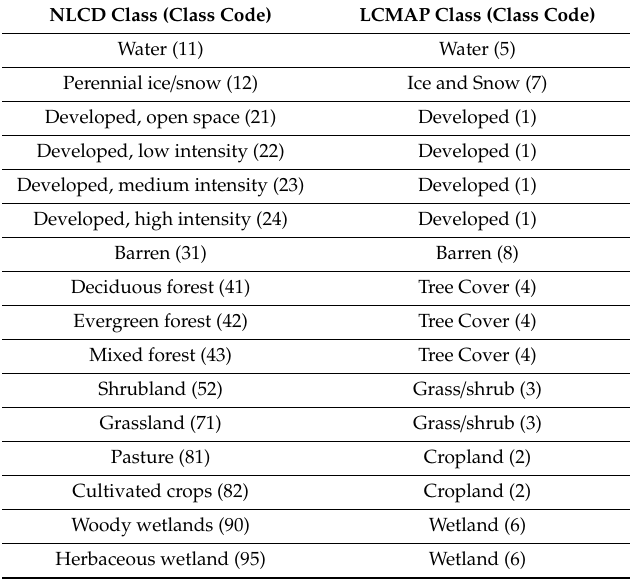
Table 1. The translation from NLCD to LCMAP classes. Values in parentheses are the land cover class